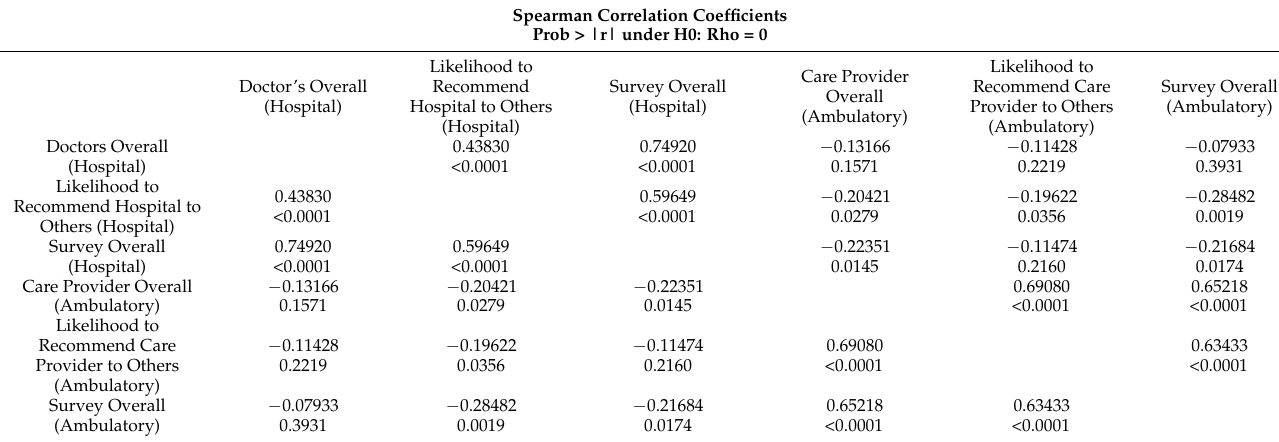
Figure 2. Mean and standard deviation histogram of Press Ganey scores for hospital survey patients who also completed at least one ambulatory survey. Table 2. Spearman correlation coefficients of hospital survey patients who also completed at least one ambulatory